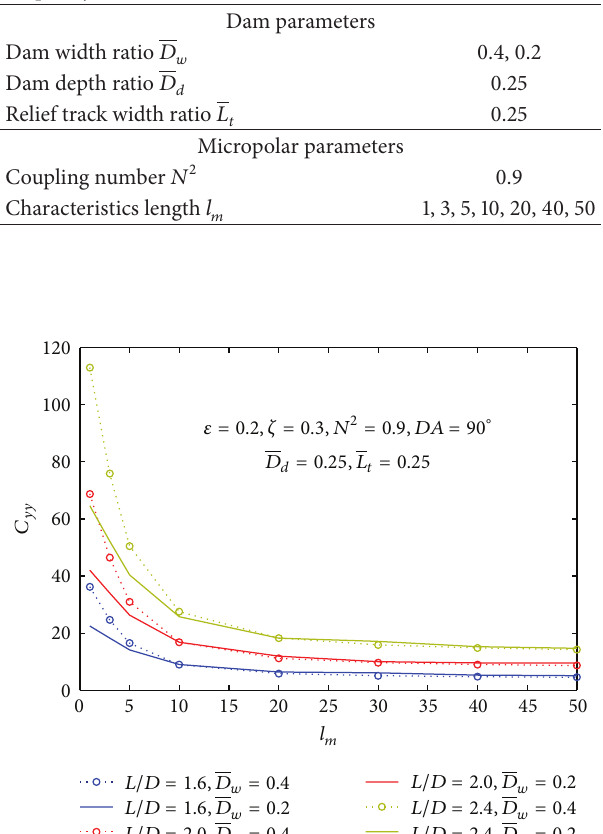
Figure 12: Variation of C 𝑦𝑦 as a function of characteristics length .” “ l m